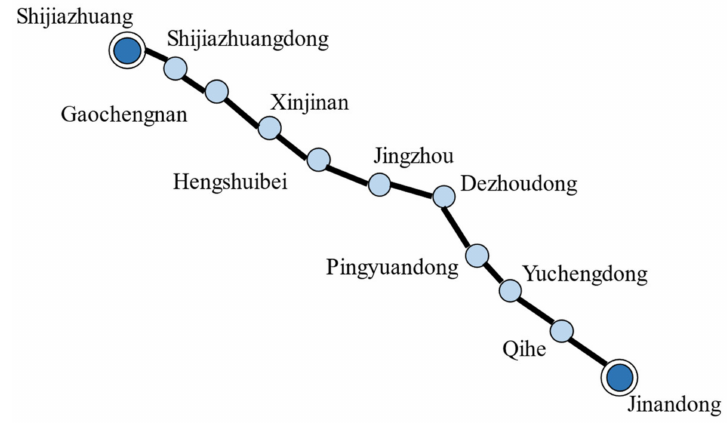
Figure 5. Map of the Shi-Ji high-speed railway line.